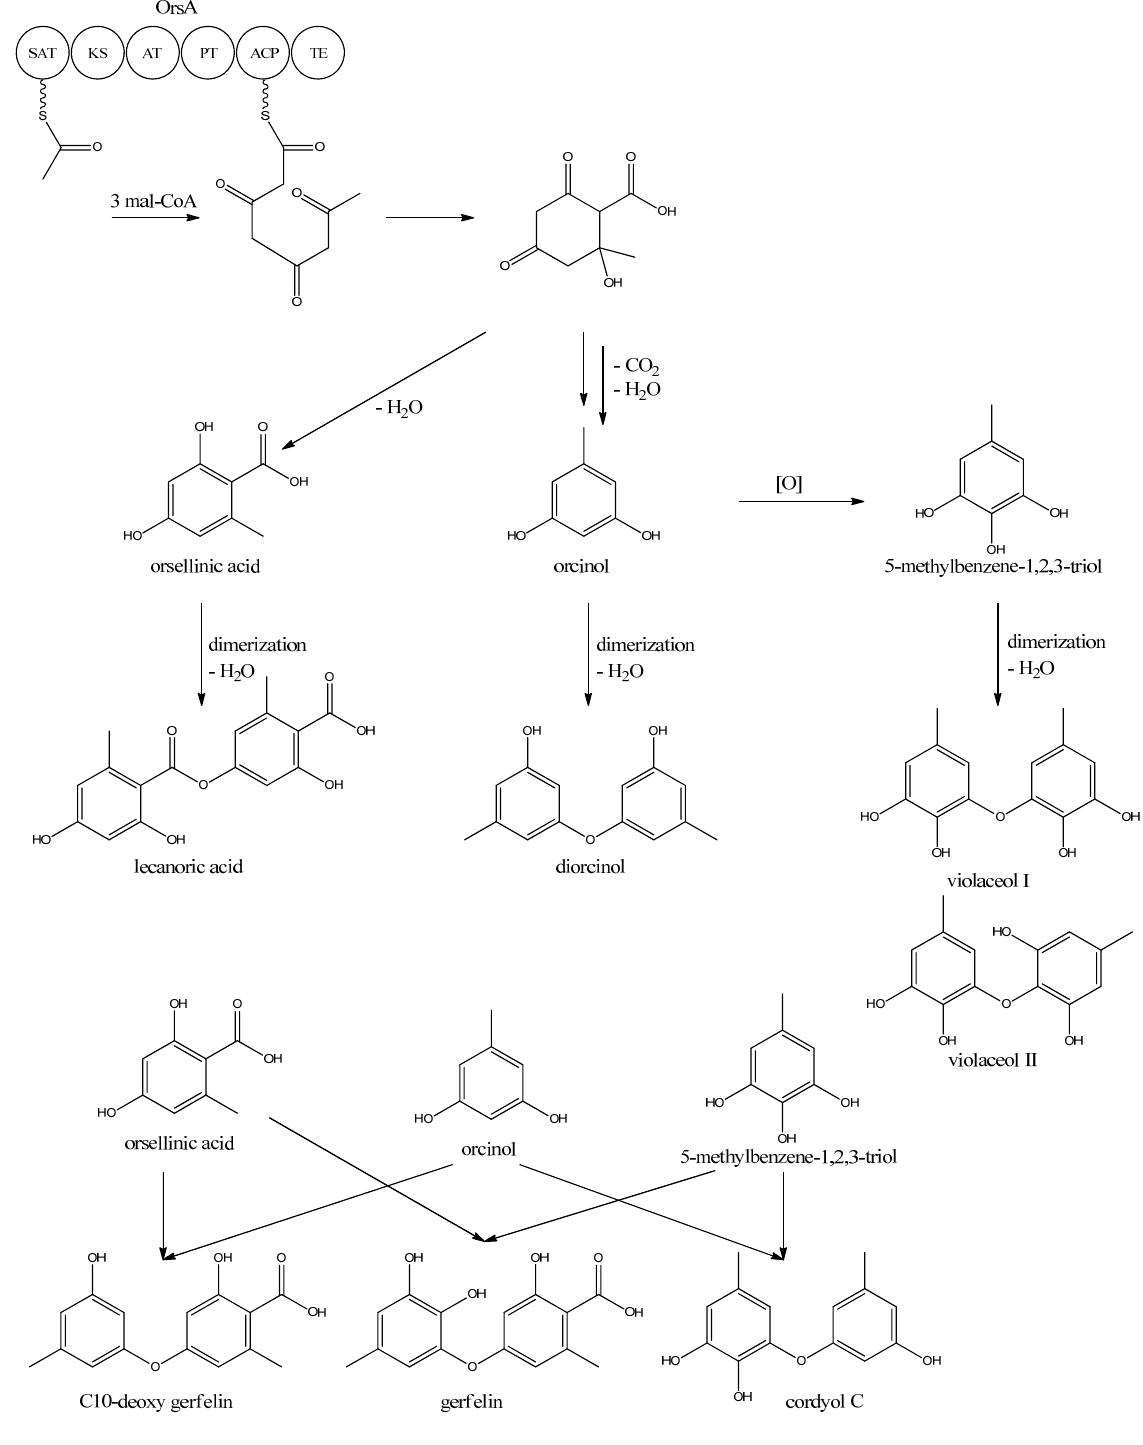
Figure 11. Proposed biosynthesis of orsellinic acid and its derivatives of orsellinic